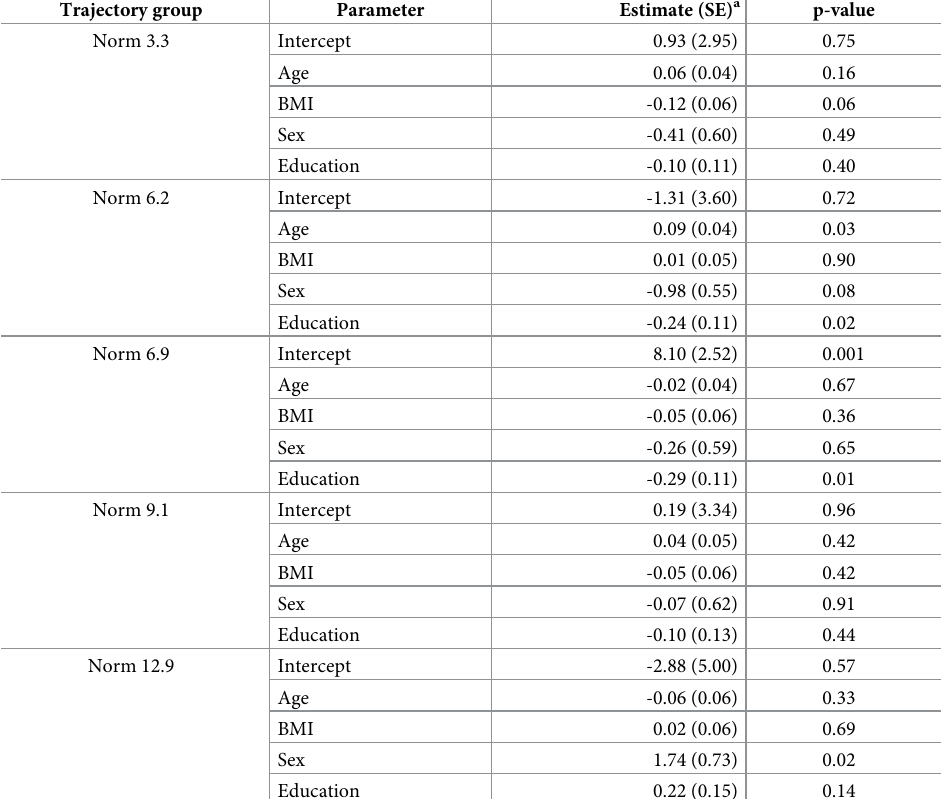
Table 5. Parameter estimates for risk factors associated with each trajectory group in normal